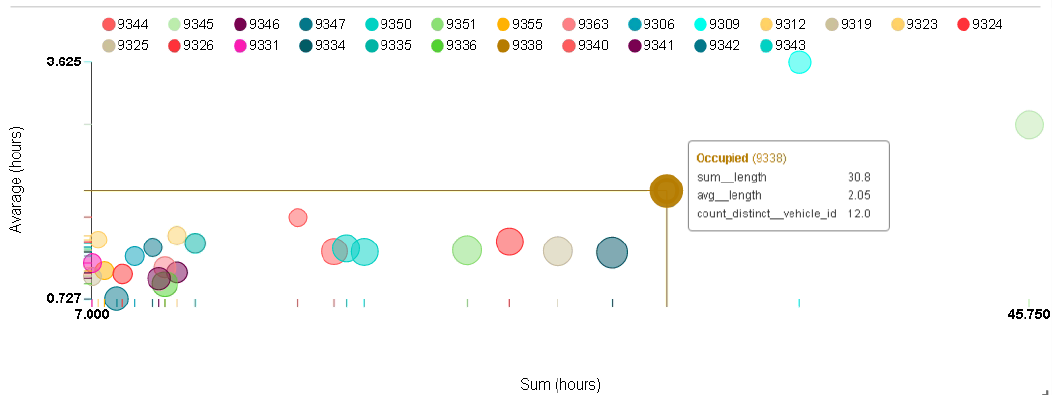
Figure A1. Parking usage pattern at each spot on 14 May